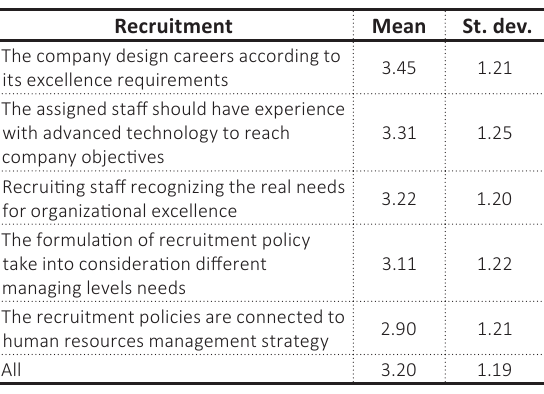
Table 2. Managers’ attitudes for the role of SHRM recruitment component toward